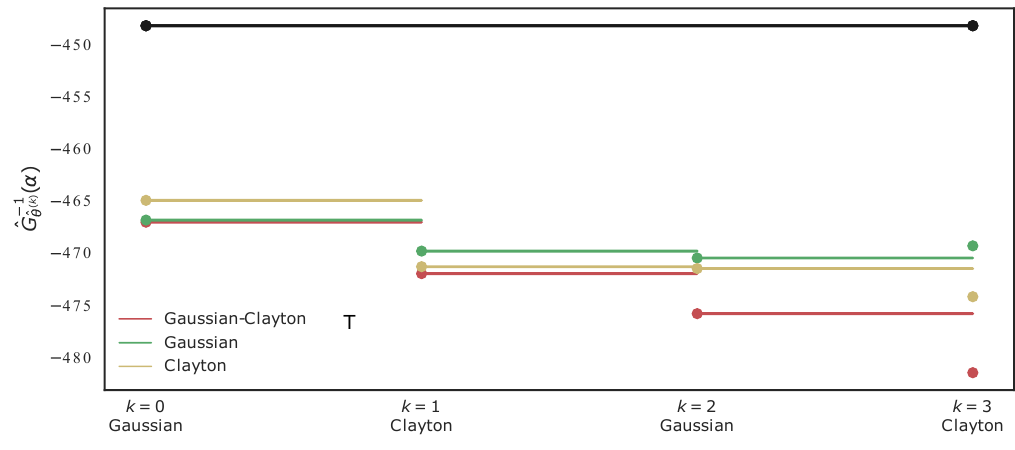
Figure 6: Quantile minimization for different set of family candidates B . The black line shows the quantile at independence. The minimum at each iteration for the family candidates sets B 1 , B 2 and B 3 respectively in red, green and